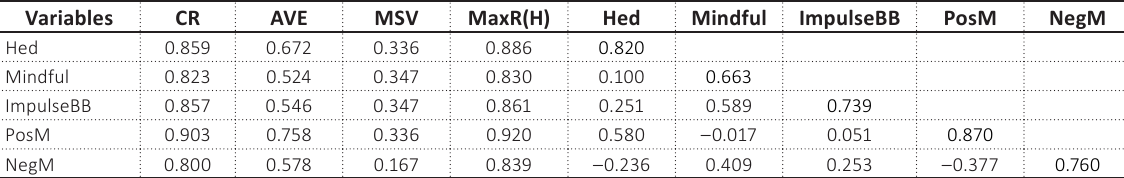
Table 4. Result of validity analysis